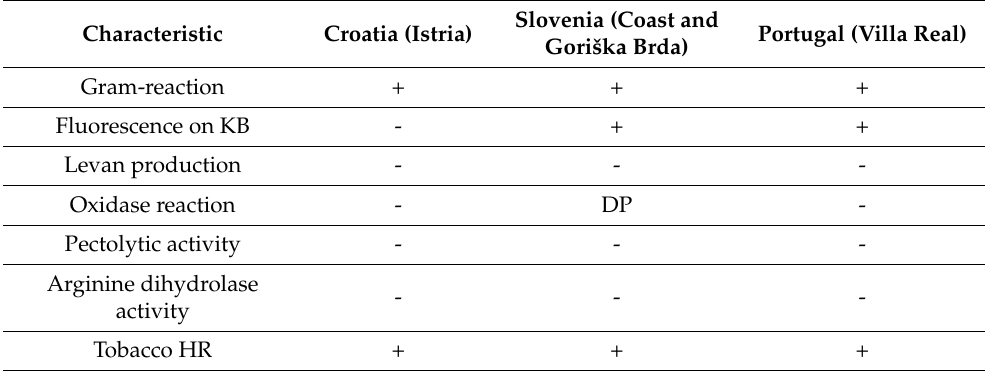
Table 3. LOPAT characteristics of P. savastanoi pv. savastanoi isolates from Croatian, Slovenian and Portuguese olive orchards. Characteristic Croatia (Istria)